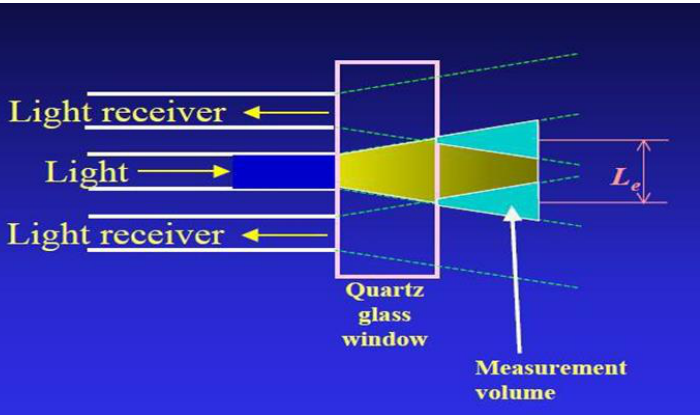
Figure 5. New Optical Probe with a Quartz Window That Eliminates the Blind Region (Institute of Process Engineering of the Chinese Academy of Sciences).